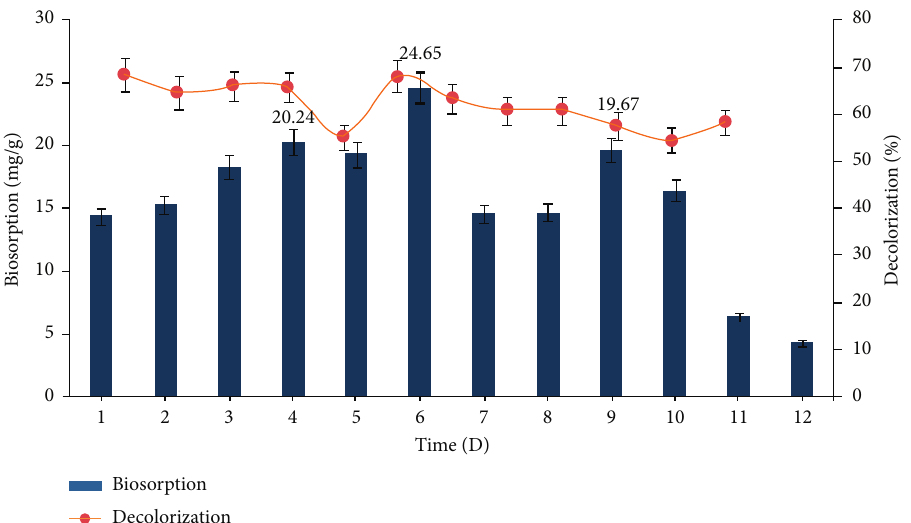
Figure 5: Proportionality of biosorption to the percentage of decolorization in the anaerobic treatment of synthetic textile effluent containing 500mg/L of mixed azo dyes in